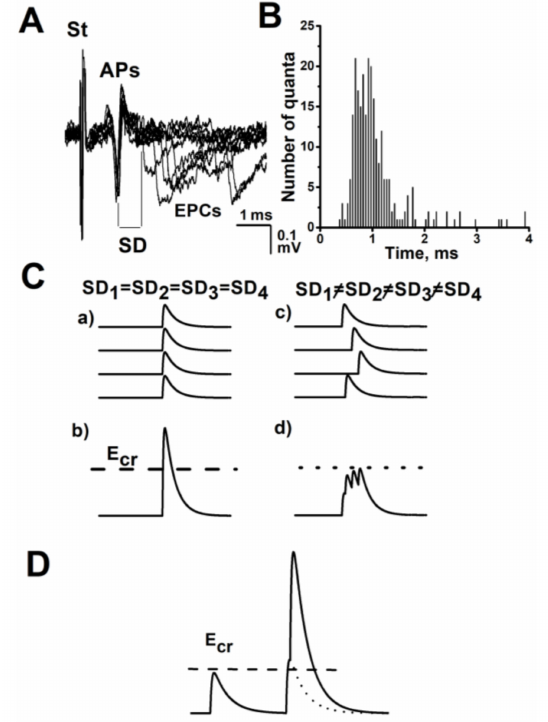
Figure 1. Asynchronous evoked phasic ACh release at the frog neuromuscular junction under low extracellular Ca 2+ concentration and scheme demonstrating the role of asynchronous quantal release after a nerve stimulus in the formation of a multiquantal postsynaptic response. ( A ) Superimposed extracellular recordings of action potentials of the nerve terminal and uniquantal end-plate potentials under a low extracellular Ca 2+ concentration. St—nerve stimulus; Aps—nerve action potentials; EPCs—end-plate currents; SD—real synaptic delay. ( B ) Histogram illustrating the distribution of synaptic delays of the uniquantal EPCs (data from single experiment). The bin size was 0.05 ms. ( C ) Summation of the uniquantal responses with equal time moments of release (a) and (b) as well as with different time moments of release (c) and (d); dash line and Ecr—the threshold for generation of muscle action potential, i.e., E critical level. ( D ) Scheme of generation of muscle action potential when the end-plate amplitude reaches the threshold for generation of the muscle action